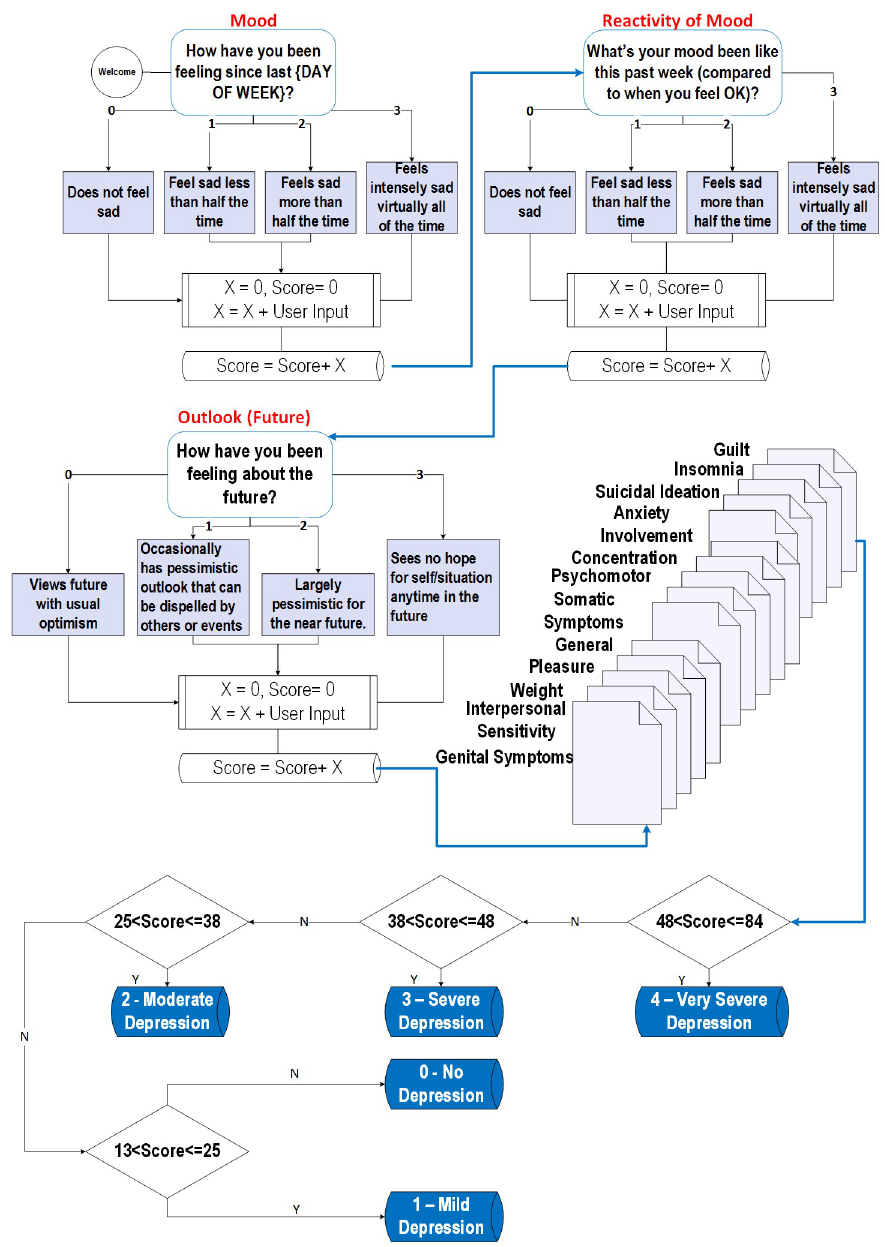
Fig 4. Flowchart summarizing the symptoms and relations between the